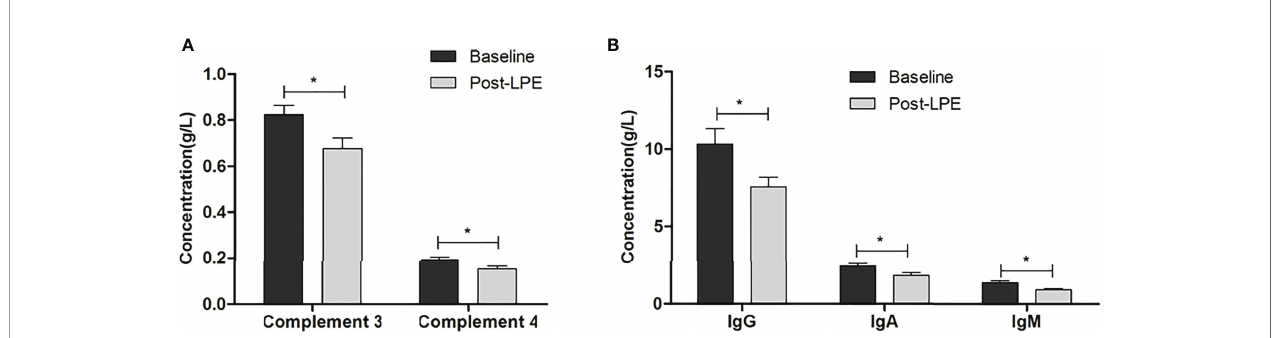
FIGURE 4 | LPE reduced serum levels of immunoglobulins and complements after LPE therapy. (A) LPE reduced serum concentrations of complement C3 and C4 (n = 186). (B) LPE reduced serum concentrations of immunoglobulins (IgA, IgG, IgM) (n = 166) (*p < 0.05). LPE, lymphoplasma exchange.